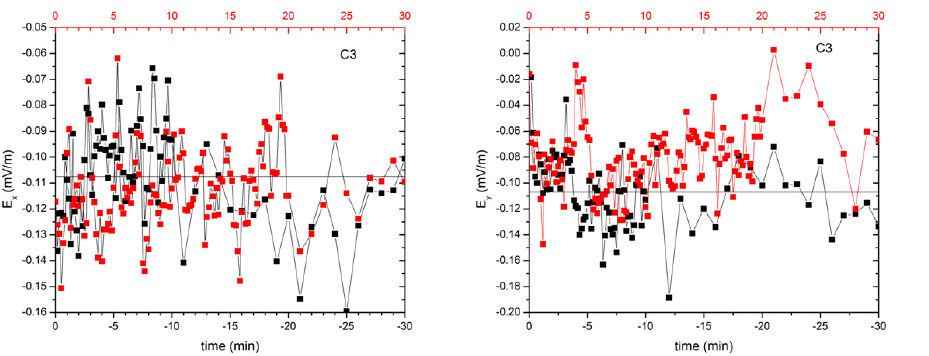
and E (in mV/m), observed along the AB and AC dipoles, respectively, related to the shot in Figure 7. Natural electric field components, E x y C3. Black symbols are used for data measured 30 min before the shot, while red symbols are used for data registered 30 min after the shot. The zero time of both the black and red scales corresponds to the shot time. The black continuous line represents the average value of the field component before the